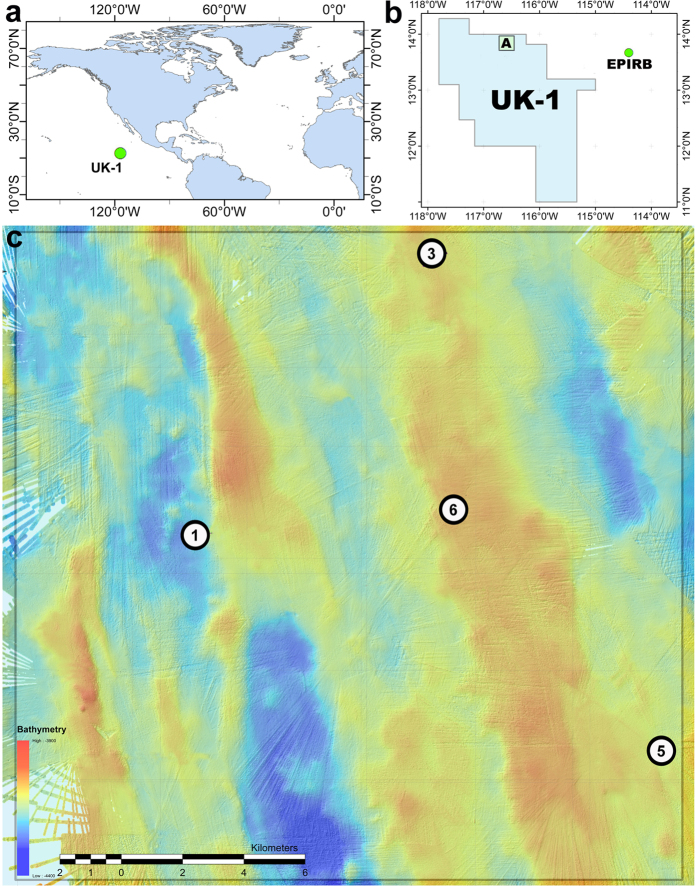
Locations of megafaunal surveys during ABYSSLINE cruise 01 (AB01) in the eastern Clarion-Clipperton Zone.(a) The location of the UK-1 exploration contract area in the Pacific Ocean. (b) The location of UK-1 Stratum A in relation to the UK-1 contract area and the AB01 ROV dive site, EPIRB, which was approximately 250 km east of the UK-1 contract area. (c) A bathymetric map of UK-1 Stratum A with the locations of ROV dives indicated by circles with the dive number. All maps were created by Seafloor Investigations Ltd. for the ABYSSLINE Project using ArcGIS software (https://www.arcgis.com/features/). (c) was created using unpublished ship-based bathymetry collected during AB01.